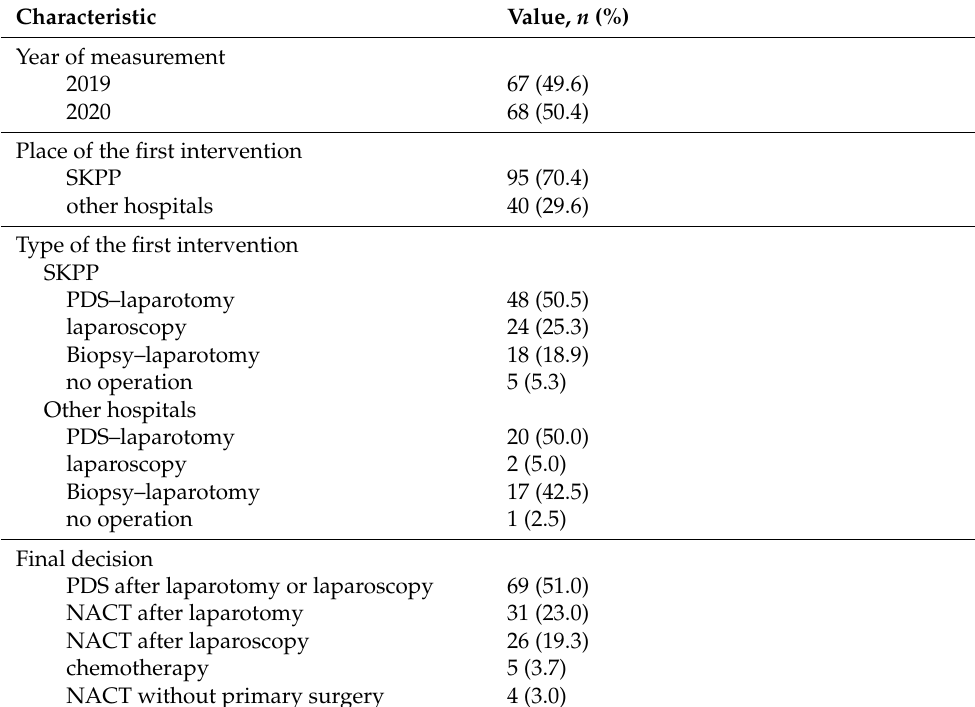
Table 1. Baseline characteristics of the study